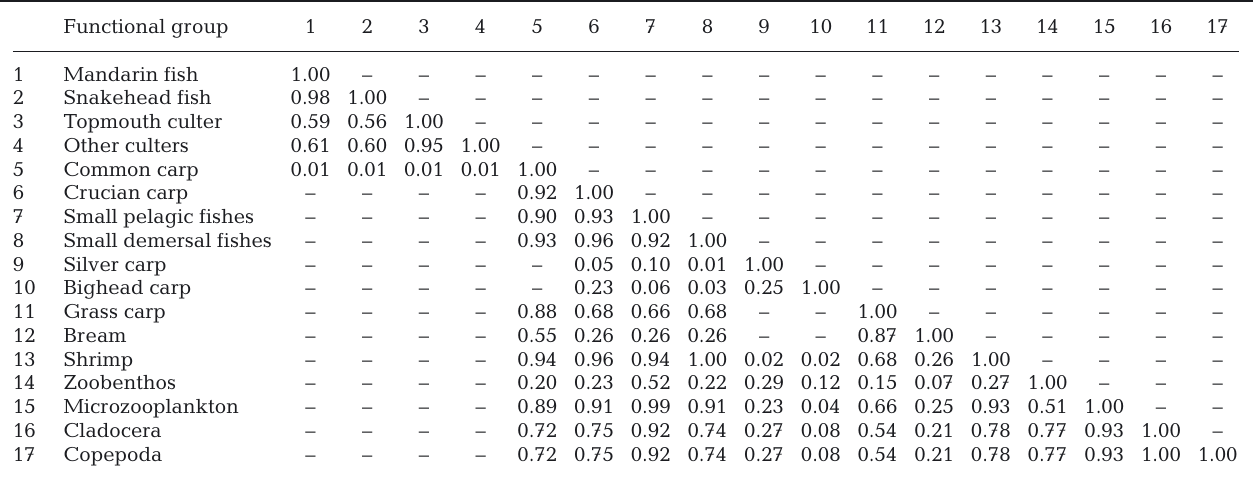
Table 5. Predator overlap indices between functional groups in the Lake Shangshe ecosystem. –: no data